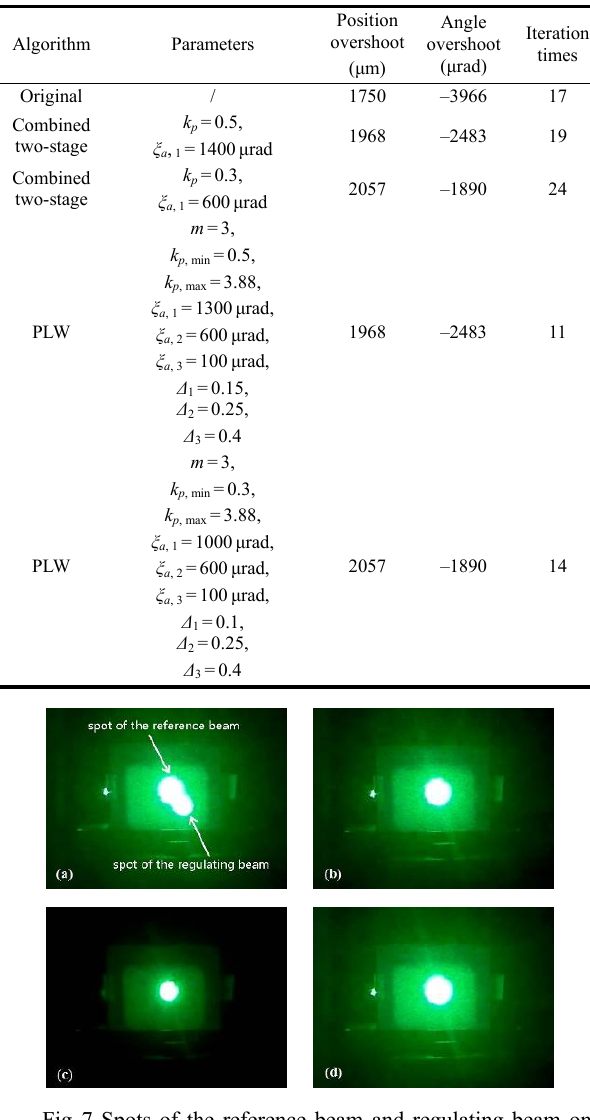
Table 1 Parameters for the simulation and simulation results